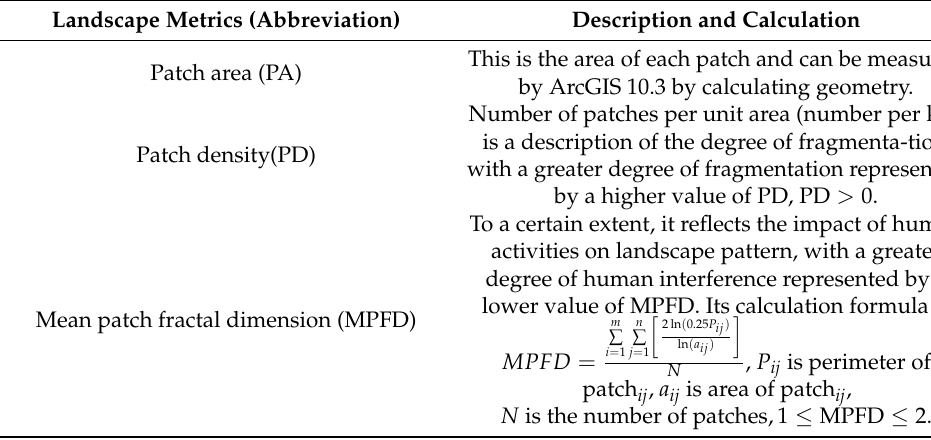
Table 3. Landscape metrics used in this